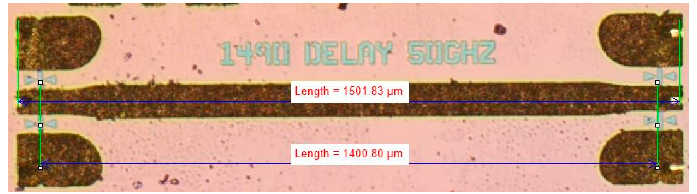
Figure 4. Sample of delay line from the on-wafer TRL calibration standards.